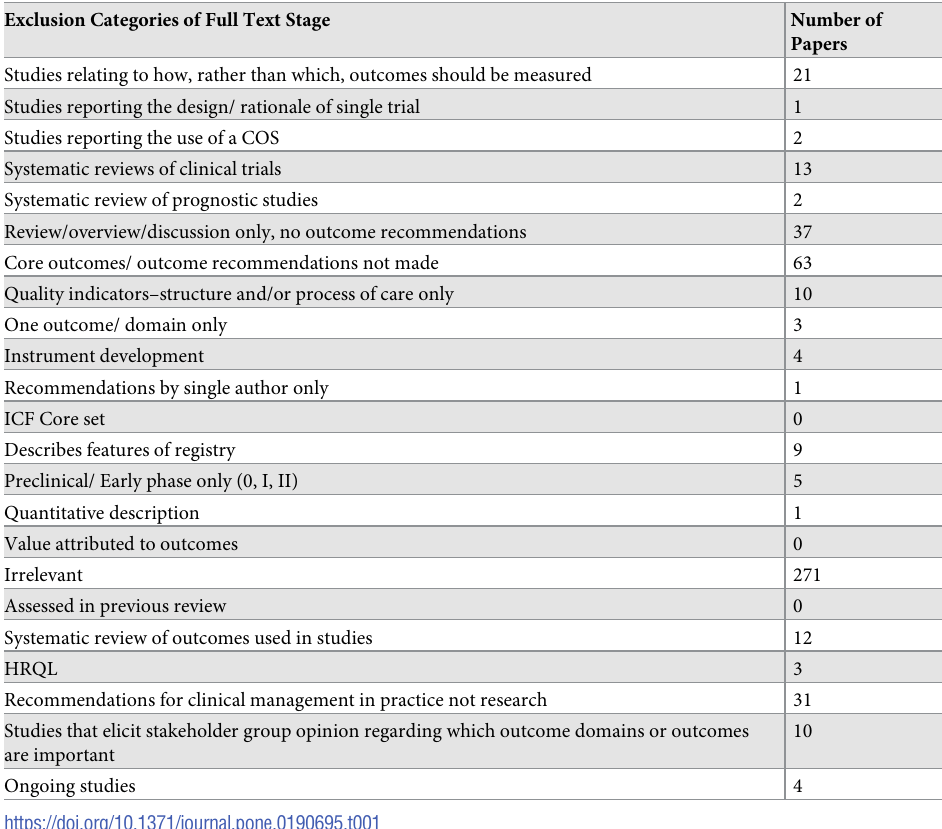
Table 1. Reasons for exclusion at full text